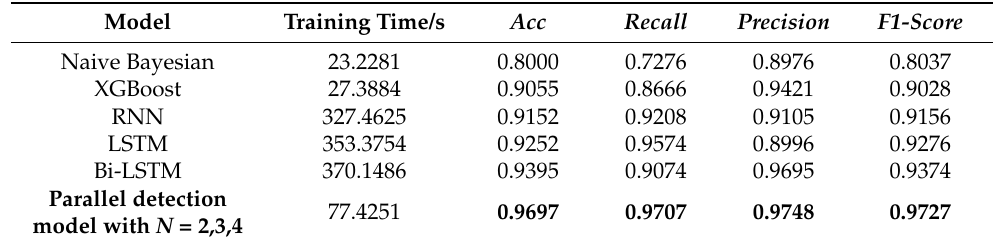
Table 5. Comparison of model training algorithms. The parameters in the experiments are set as follows: the Naive Bayes algorithm and XGBoost algorithm both use features extracted by bigram for processing. The output dimension of the RNN hidden layer was 64, and the output dimension of the Relu activation function was 32; the output dimension of the LSTM hidden layer was 64; the loss rate of the dropout layer was 0.1, and the rest of parameters in the network are default values.